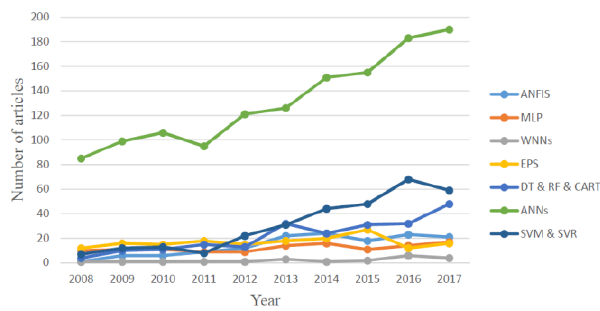
Figure 1 . Primary ML methods are used for flood prediction in the literature. Reference year: 2008 (source: Scopus adapted from Mosavi et al., 2018).